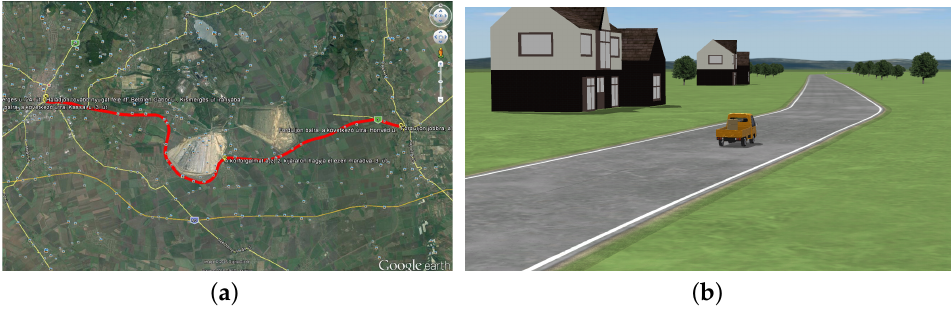
Figure 8. ( a ) Real data simulation route. ( b ) TruckSim environment.